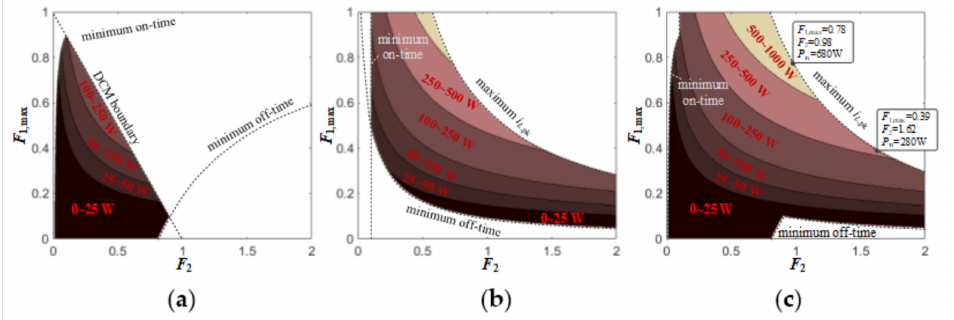
Figure 10. Input power with consideration of minimum on/off times and current stress. ( a ) VoT control to achieve DCM; ( b ) CoT control to achieve CRM; ( c ) TACC control to achieve mixed